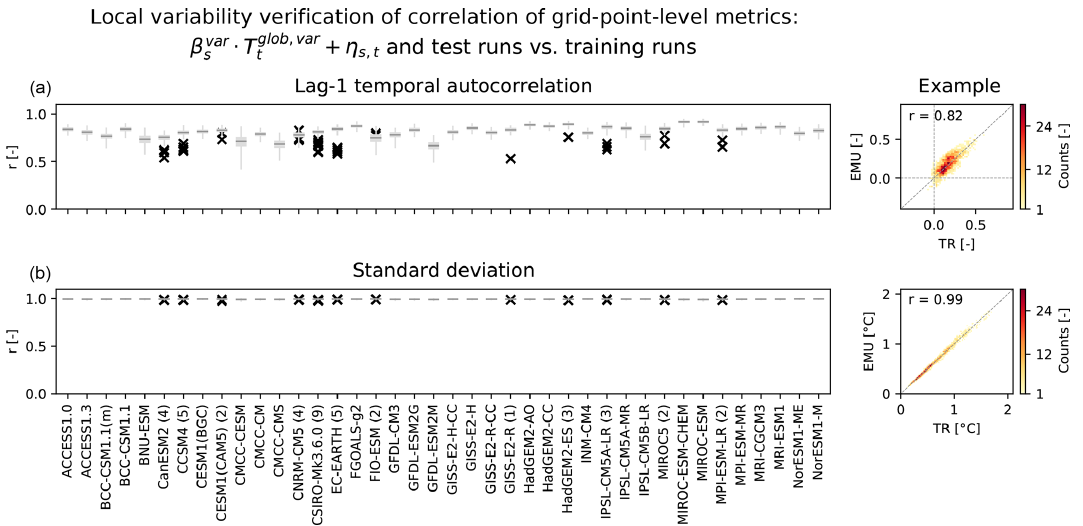
Figure 10. Local variability verification for the CMIP5 models (columns) by means of the Pearson correlation of grid-point-level lag-1 temporal autocorrelations (a) and standard deviations (b) between the 1000 individual emulations and the training runs (box plots). The examples show the associated 2-D histograms for a single emulation and the training run of CESM1(CAM5). For the CMIP5 models with test runs, the correlation between the quantity in the training run and in each individual test run is indicated by a black cross. For all climate models with test runs available, the number of test runs is given in brackets after the model name.